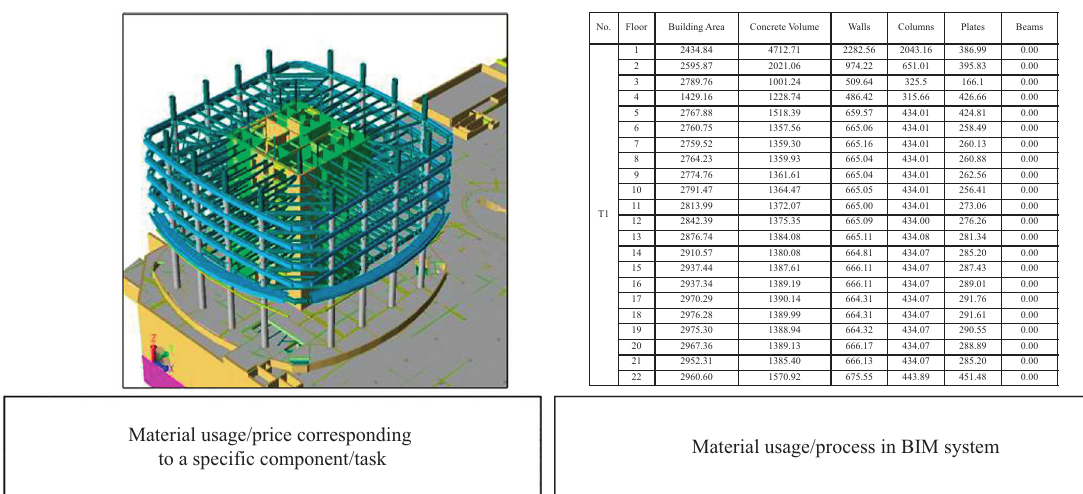
Figure 17: Enterprise quota management based on BIM.